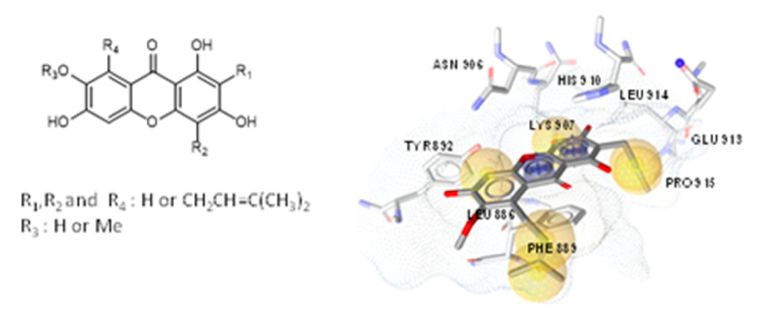
Figure 30. Structure of synthesised xanthones and docking post of α -mangostin in the cytosolic domain of IRE1.